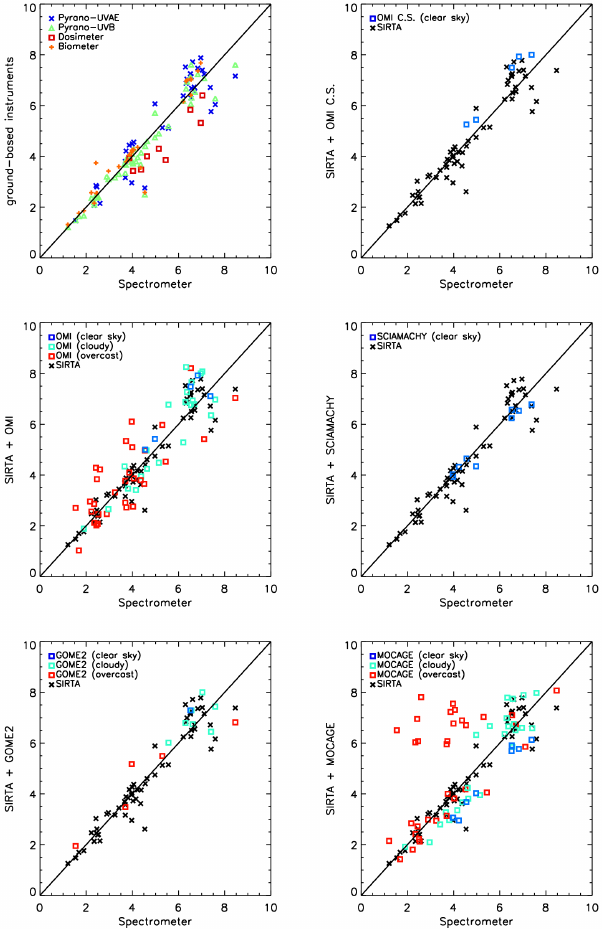
Fig. 8. From top left to bottom right: correlations between UVI spectrometer observations and the ground-based instruments, the OMI, the GOME2, the OMI-CS, the SCIAMACHY, and MOCAGE products over the RISC-UV campaigns. Correlation between the mean value of the SIRTA instruments (Pyranometer UVAE, Pyra- nometer UVB, Biometer) and the spectrometer have been system- aticaly overplotted (black cross). In few panels a cloud color classi- fication has been used to evaluate the correlation in function of the cloud coverage (red: overcast, clear blue: cloudy, blue: clear sky conditions).